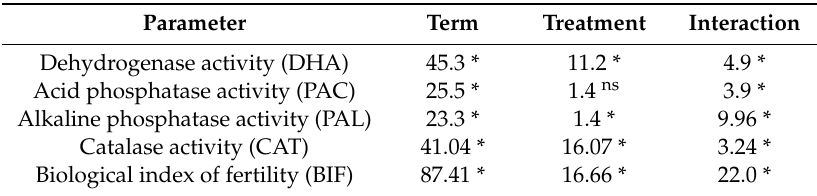
Table 6. The test F statistics and the significance level of two-way analysis of treatments for the enzymatic activity. The traits under analysis were a ff ected by two factors, i.e., cultivation system and the term of the